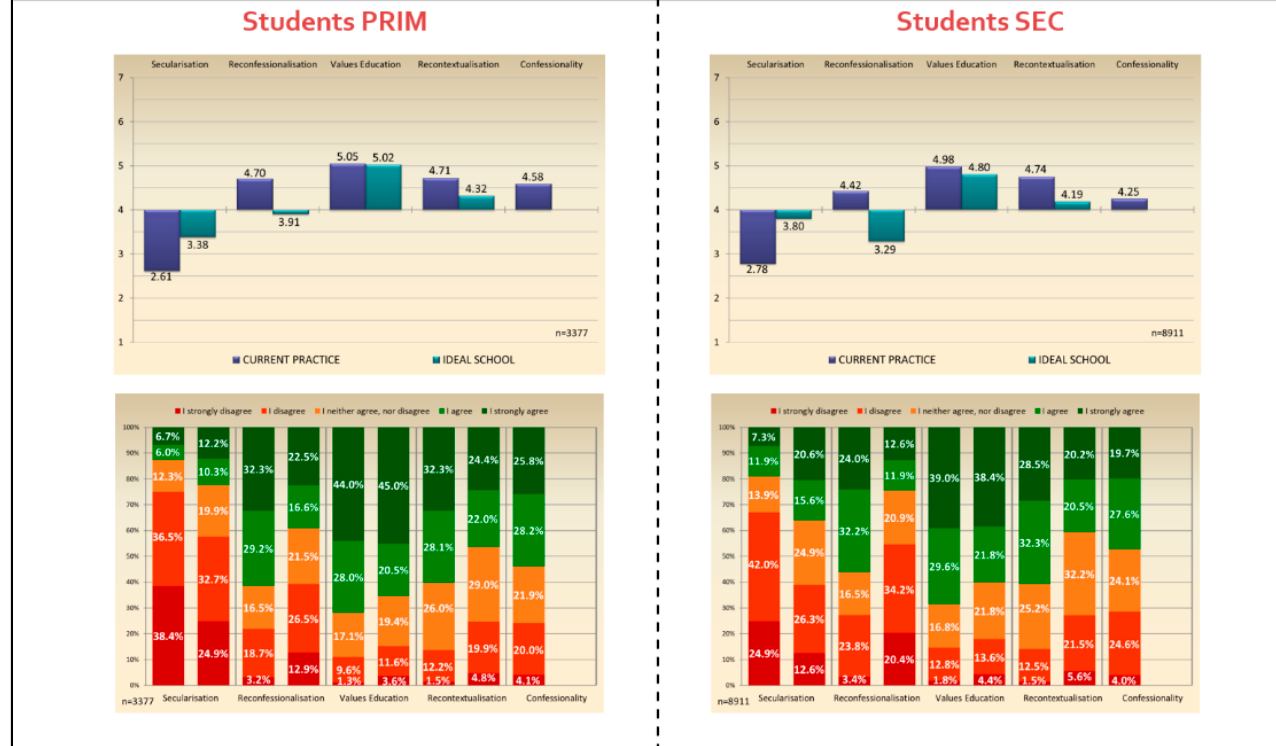
Figure 6. Melbourne Scale results among primary and secondary school students in Brisbane.